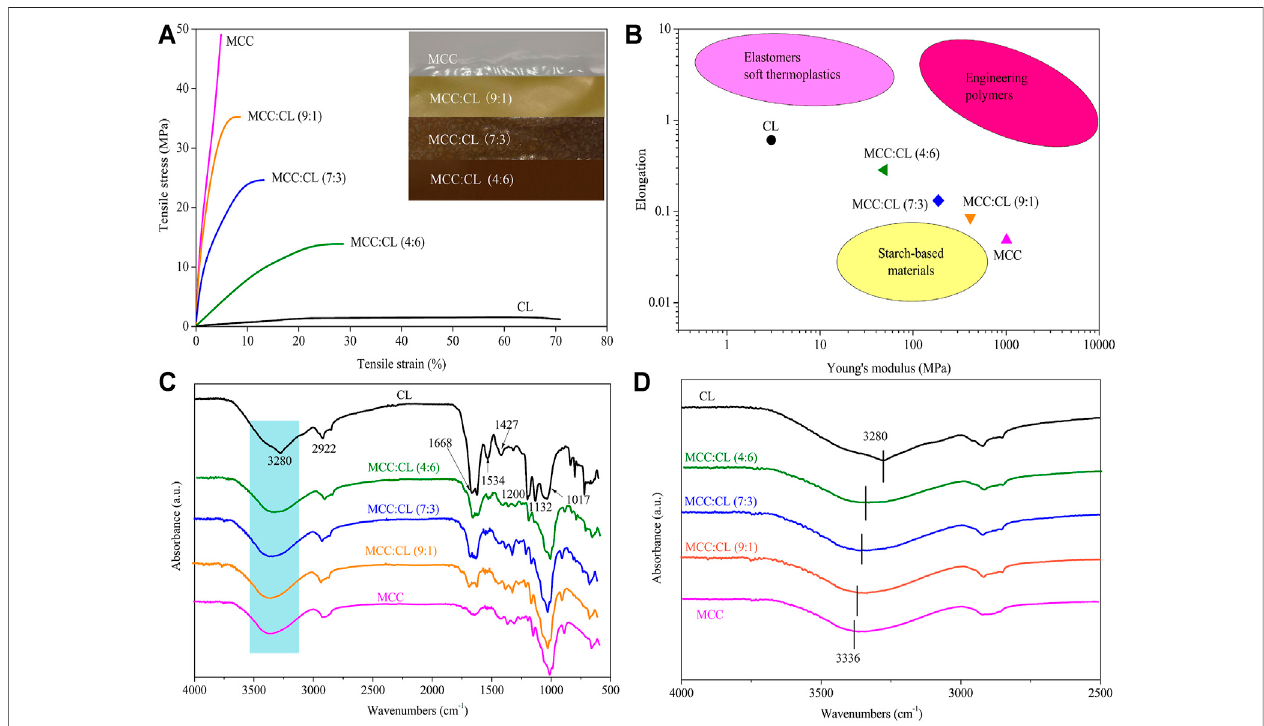
FIGURE 6 | Typical stress – strain curves for MCC:CL blends (A) ; the photograph in fi gure (A) shows the MCC fi lm and CL extract with different ratios; elongation and Young ’ s modulus data of MCC:CL blends (B) , compared with the ranges of performance of elastomers/soft thermoplastics, starch-based materials,andengineeringpolymers;FT-IRspectra (C) oftheMCC fi lm,CLextract,andMCC:CLblends;FT-IRspectra (D) ofMCC:CLblendsinthehydroxylgroup stretching region.